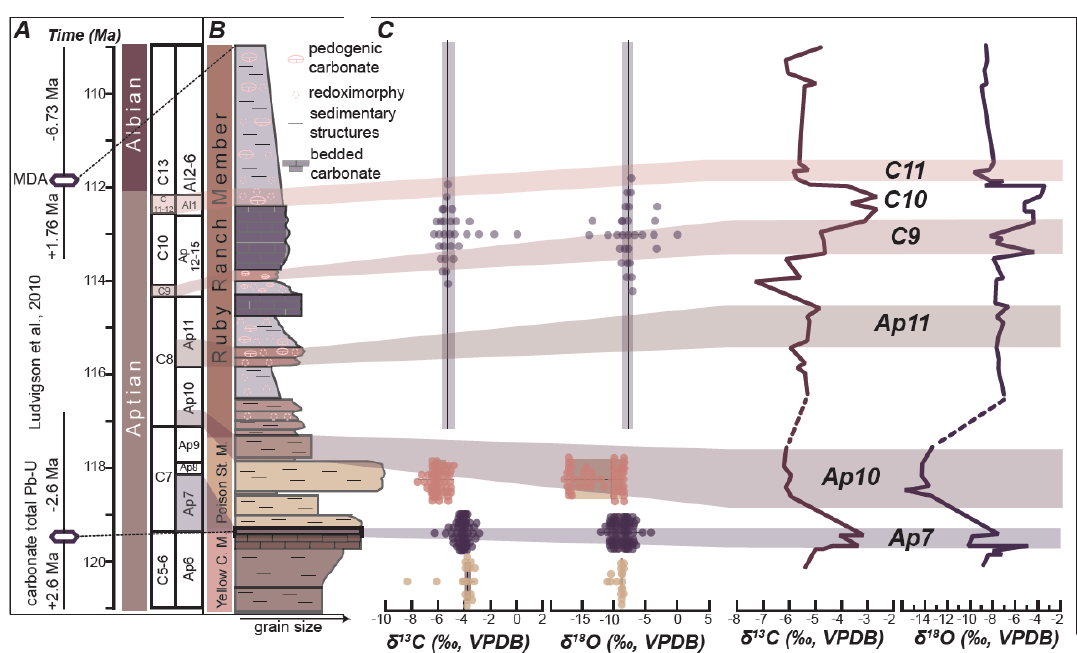
Figure 2. Summary of Cedar Mountain Formation strata discussed in this study and chemostrati- graphic correlations. ( A ) Current radiometric constraints on the Yellow Cat, Poison Strip, and Ruby Ranch members, and marine-based carbon isotope stages. ( B ) Composite stratigraphic column including field areas on the eastern San Rafael Swell and the Paradox Basin. ( C ) Summary of C and O stable isotope compositions based on individual members within the Cedar Mountain Formation and chemostratigraphic trends (after [19,40]).